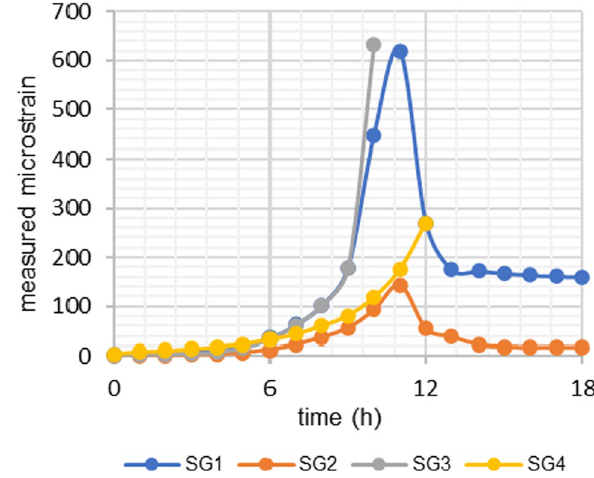
Fig. 11 Measured strains in specimen G-SL2-125-625-M-01